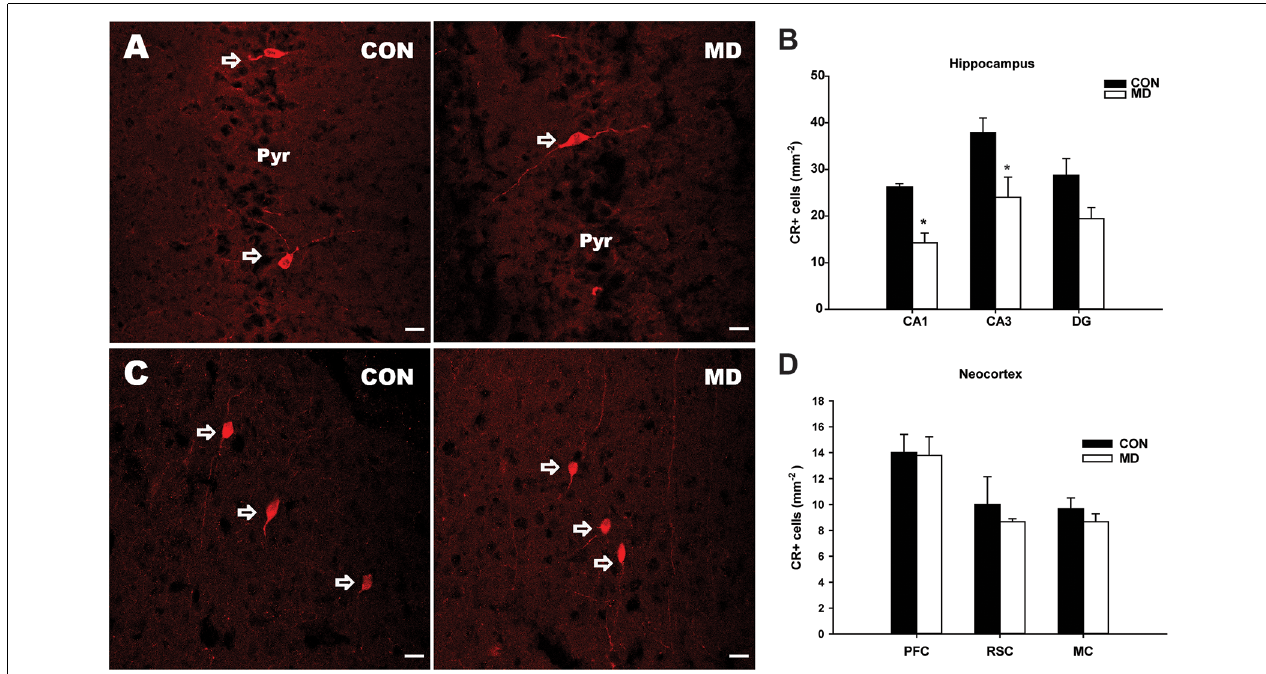
FIGURE 3 | Calretinin-expressing interneurons. (A) Representative images of immunofluorescence staining for calretinin in the CA3 region of the hippocampus a control (CON, left panel) and an MD (right panel) rat at P60. Pyr indicates a pyramidal cell layer. (B) Shown are mean values + standard error of the mean (SEM) for profile densities (number of immunopositive cells per area) of calretinin+ neurons in the hippocampus of MD and control rats (* p < 0.05, t -test, n = 6 animals per group). (C) Representative images of immunofluorescence staining for calretinin in the retrosplenial cortex of a control (CON, left panel) and MD (right panel) rat at P60. (D) Shown are mean values + standard error of the mean (SEM) for profile densities (number of immunopositive cells per area) of calretinin+ neurons in the neocortex of MD and CON rats ( p > 0.05, t -test, n = 6 animals per group). Scale bars: 20 µ